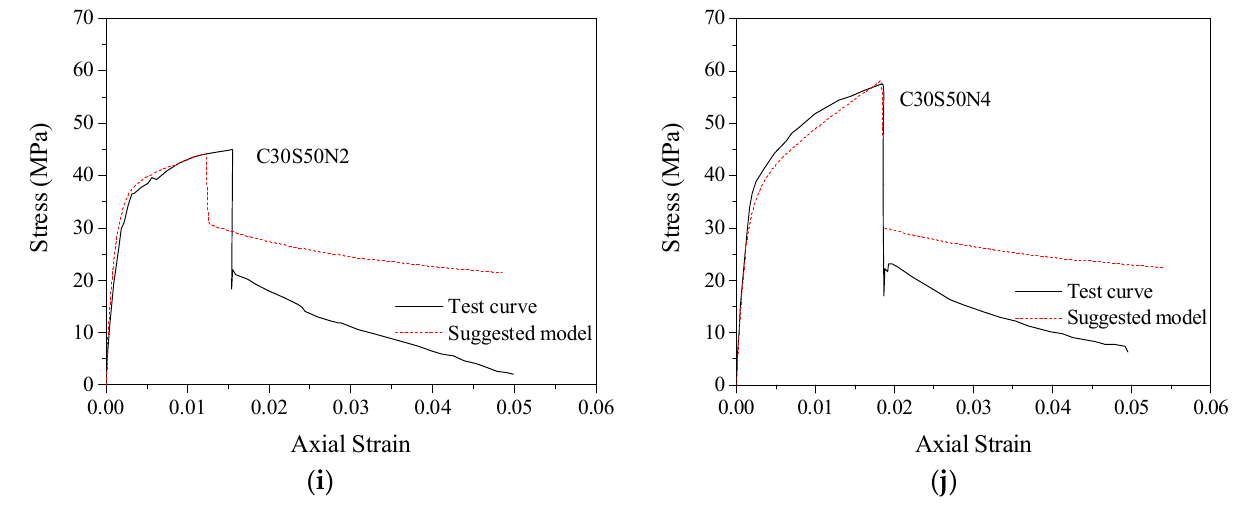
Figure 17. Performance of stress–strain relationship curve model of FRP–stirrup composite-confined concrete in the database: ( a ) R25S20C1; ( b ) R40S20C2; ( c ) R25S40C1; ( d ) R40S20C2; ( e ) QR2C2; ( f ) QR3C3; ( g ) C30S100N2; ( h ) C30S100N4; ( i ) C30S50N2; ( j ) C30S50N4.